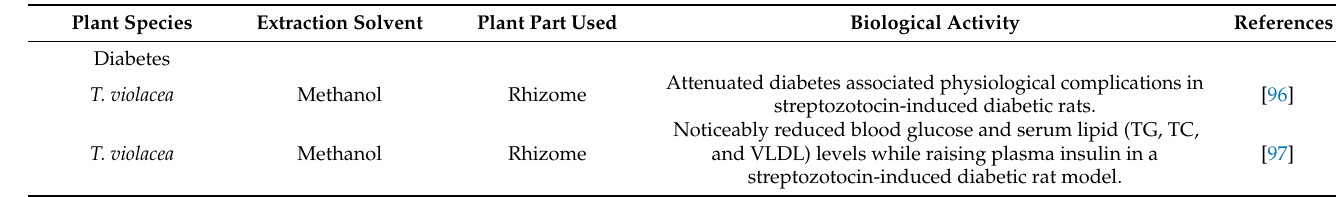
Table 7. Antidiabetic, anticardiovascular and antithrombogenic activity of Tulbaghia species. Plant